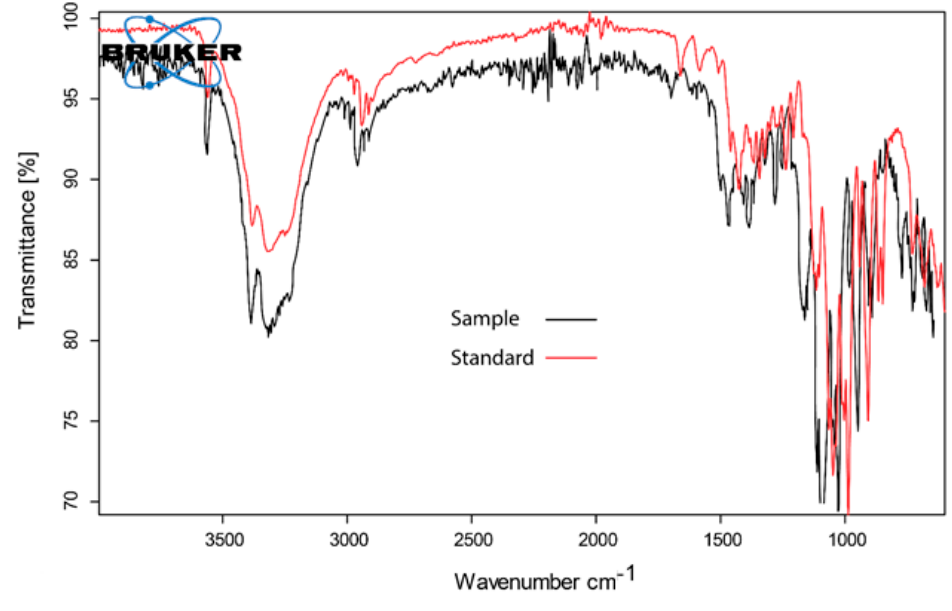
Figure 5. FTIR spectrum of biovanillin.